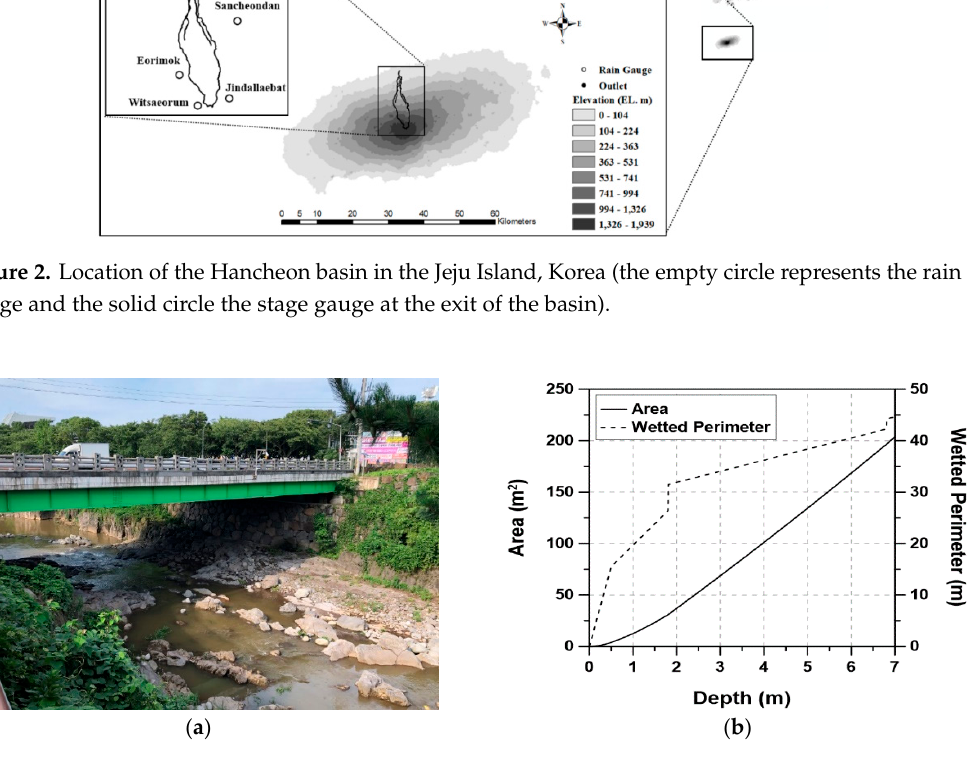
Figure 2. Location of the Hancheon basin in the Jeju Island, Korea (the empty circle represents the rain gauge and the solid circle the stage gauge at the exit of the basin).